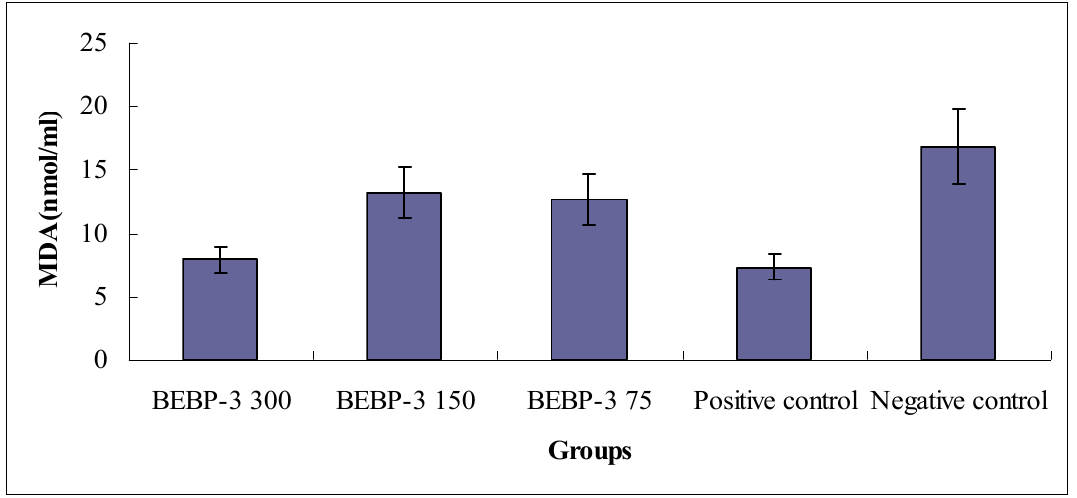
Figure 6. Determination of MDA contents in blood serum from the mice. Results are presented as means ± standard deviations. The positive control is Vc (150